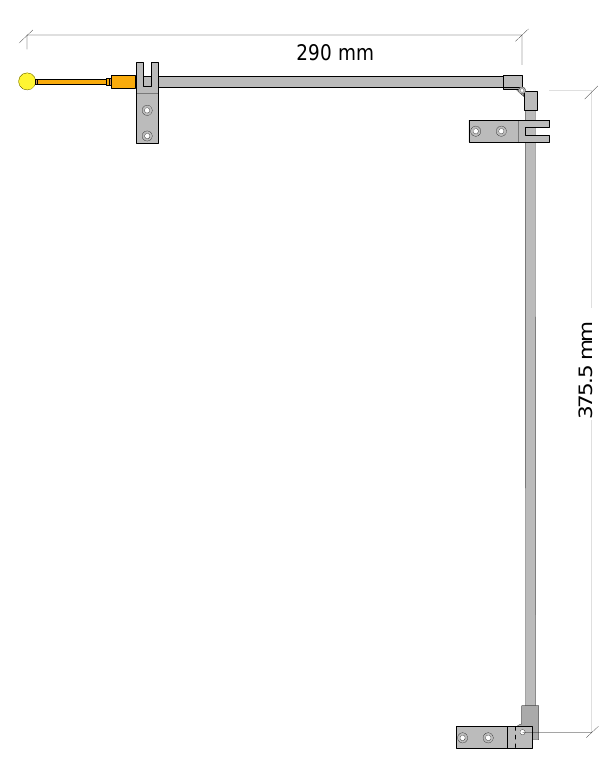
Fig. 5. The boom and Probe assembly shown in the folded position.